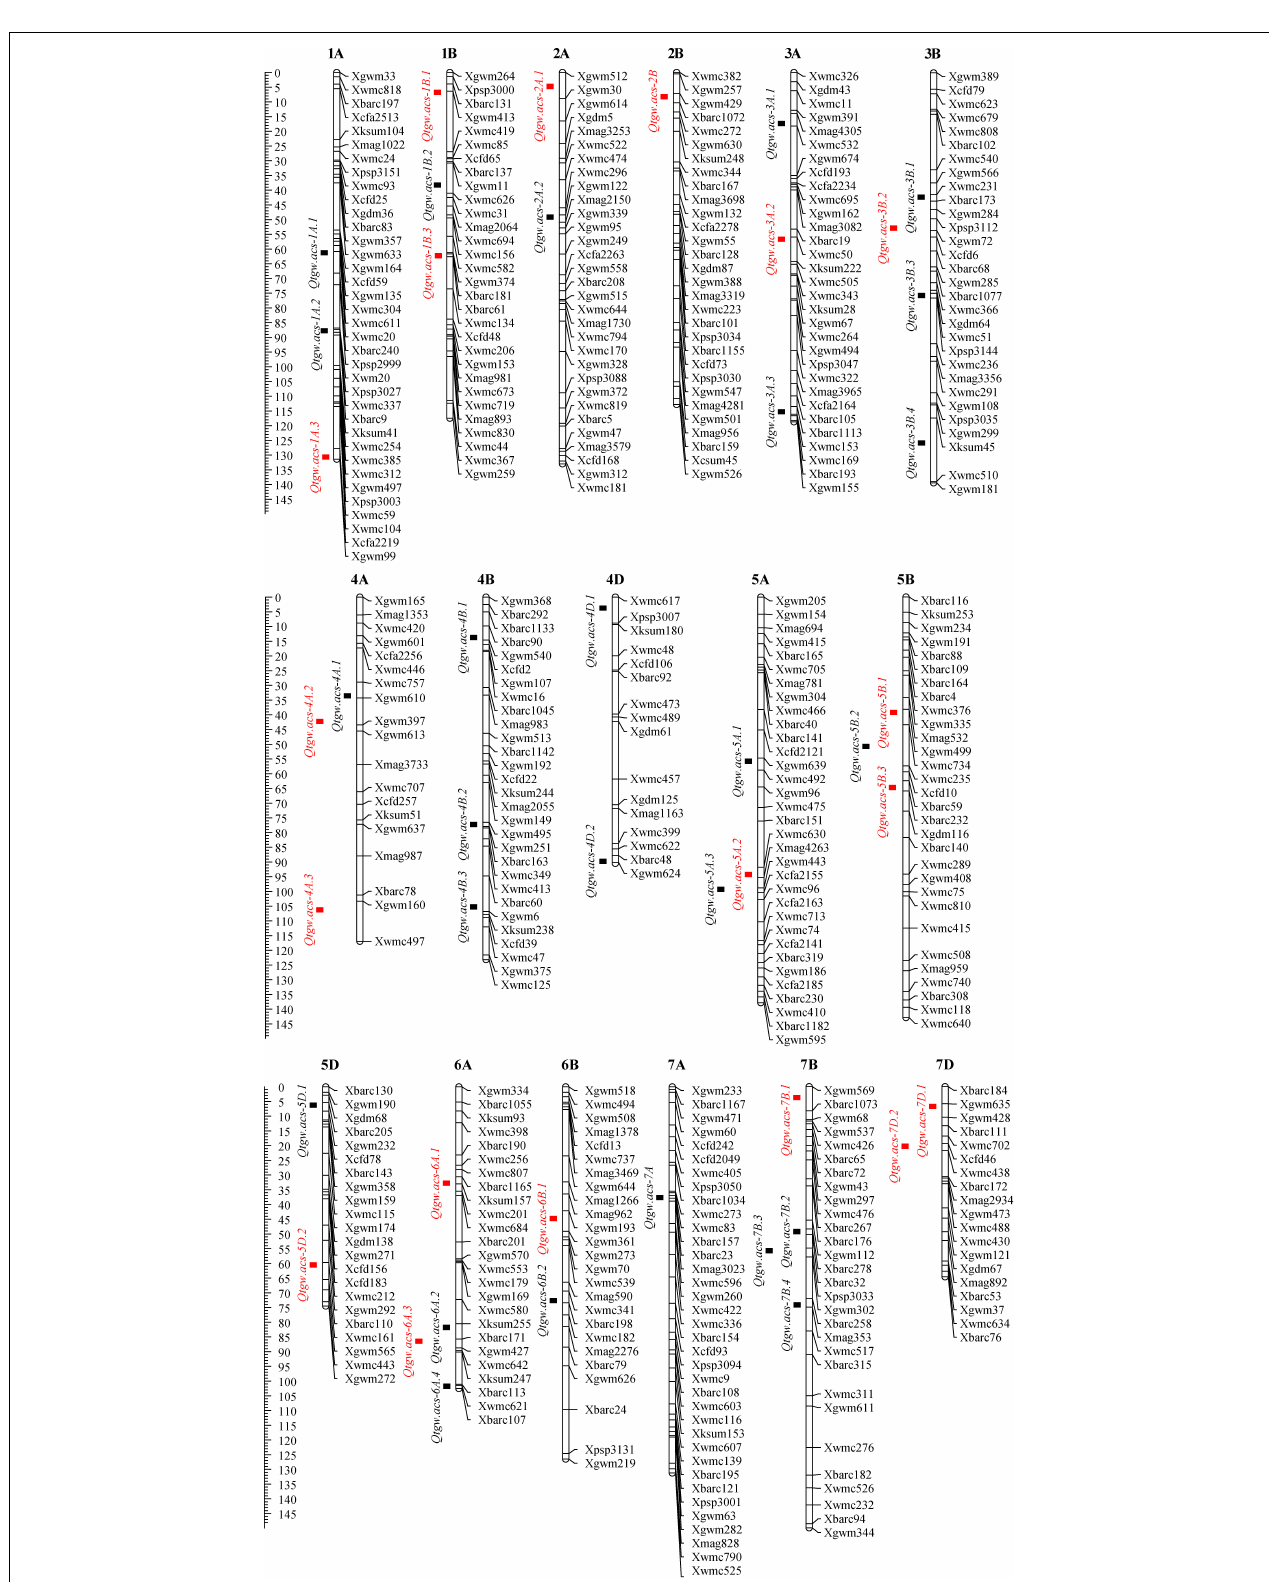
Frontiers in Plant Science |